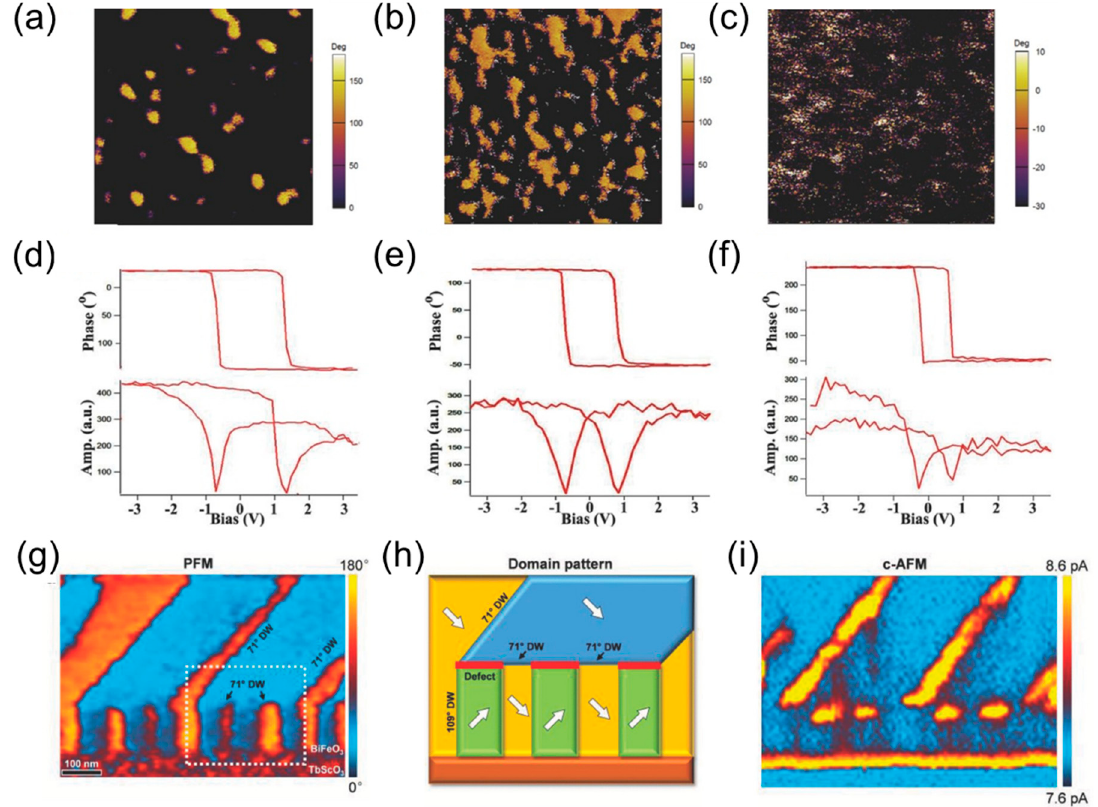
Figure 1. Resonance tracking-piezoresponse force microscopy phase images and switching spectroscopy piezoresponse force microscopy (SSPFM) loops compare the domain state and switching behavior without STO ( a , d ), with 3 uc ( b , e ) and with 10 uc ( c , f ) thick STO spacer in the PZT / STO / PZT heterostructure. Reprinted with permission from [38], copyright Wiley-VCH Verlag GmbH and Co. KGaA, 2015. ( g – i ) Cross-sectional PFM phase image ( g ), a sketch of the domain state ( h ) and c-AFM image showing a change of domain pattern from 109 ◦ to 71 ◦ domain wall type by adding defects during the synthesis of BFO on TSO ( i ). Reprinted with permission from [47], copyright Wiley-VCH Verlag GmbH and Co. KGaA, 2015.